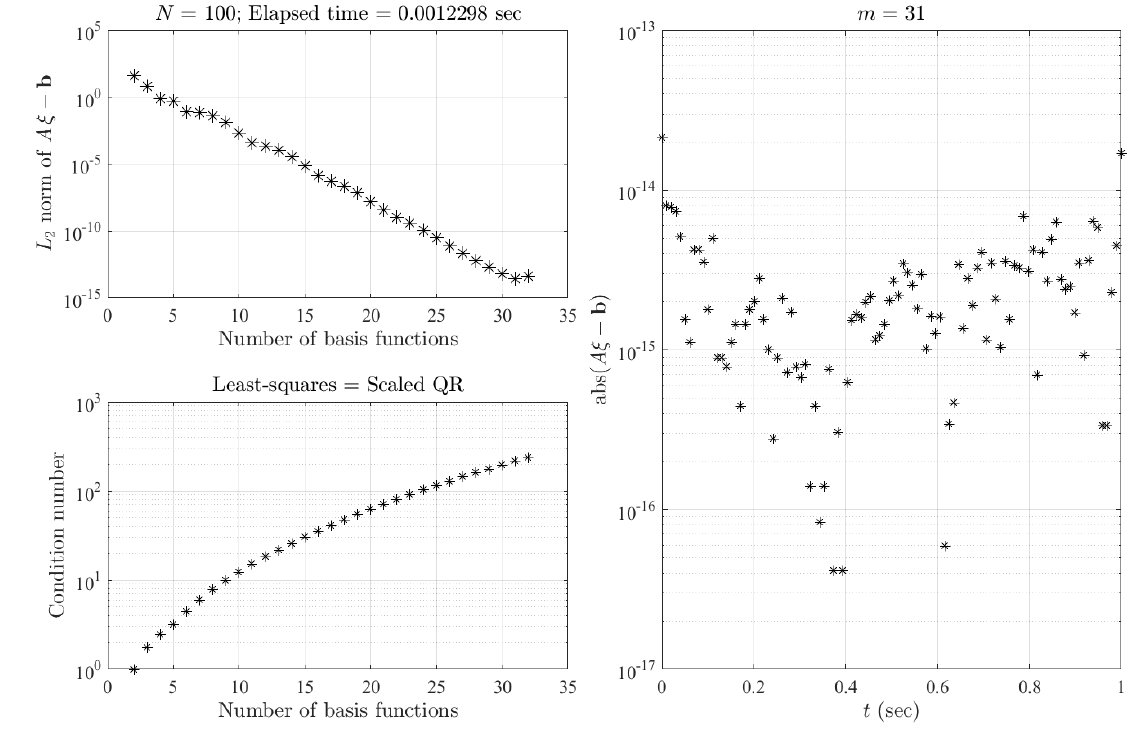
Figure 3. Least-squares-approach results (unknown analytical